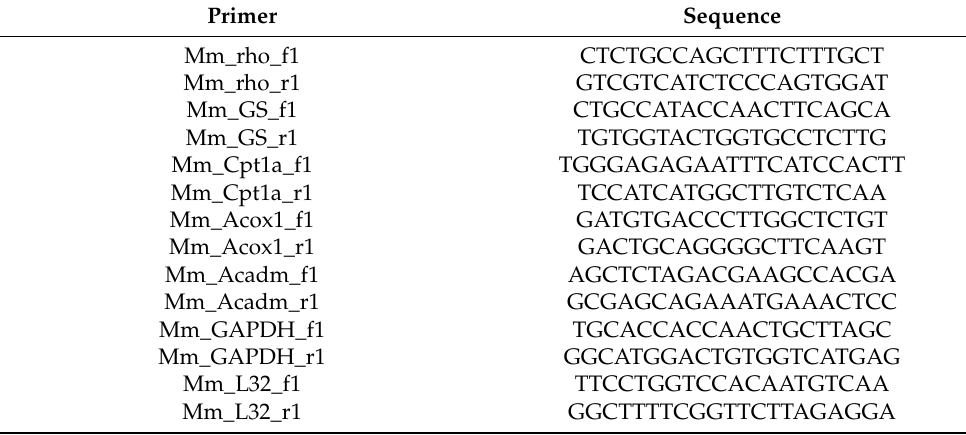
Table 1. qPCR primer